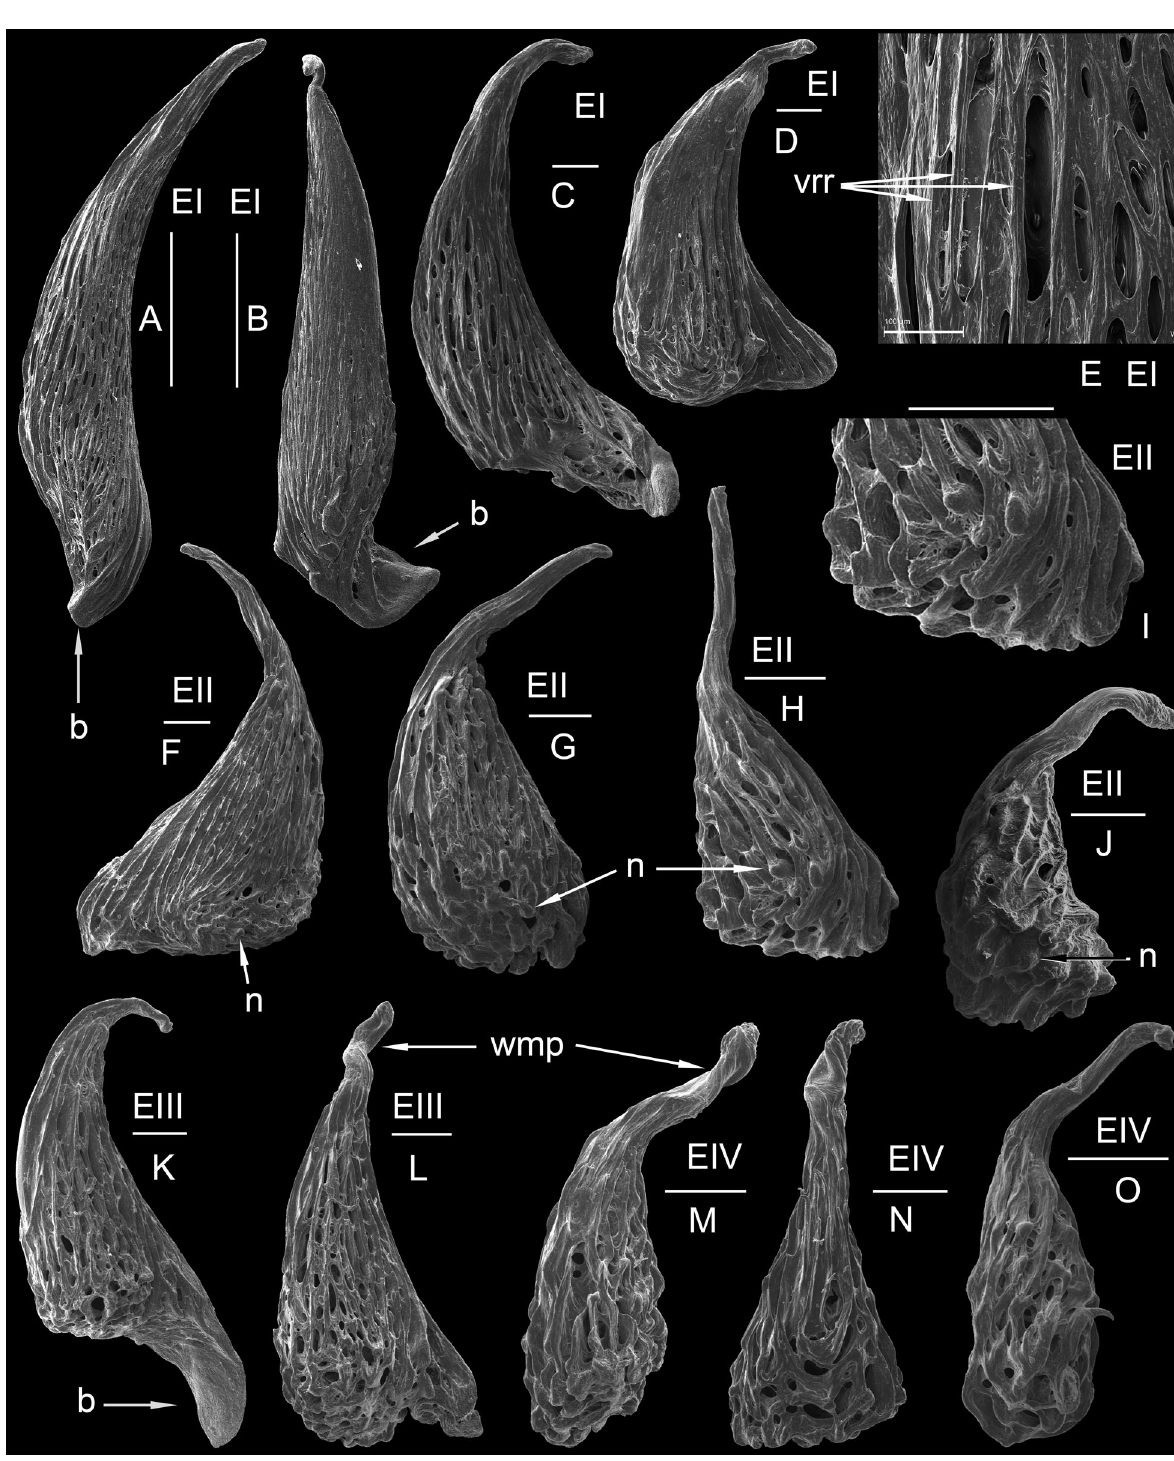
Fig. 3. Pleuronectes platessa Linnaeus. Cores of gill rakers from the 1st to 4th arches of the eye side (EI–EIV). A = E, GIT 584- 121-3; B, GIT 584-121-4; C, GIT 584-121-2; D, GIT 584-121-1; F, GIT 584-121-8; G, GIT 584-121-10; H = I, GIT 584-121-11; J, GIT 584-122-6; K, GIT 584-121-15; L, GIT 584-121-16; M, GIT 584-121-21; N, GIT 584-121-20; O, GIT 584-121-23. E is close-up of A; I is close-up of H. Scale bar for A, B is 1 mm, for C, D, F–O 200 µm. For abbreviations see Fig.